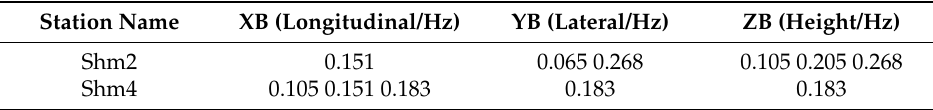
Figure 10 . FFT results of shm2 . Figure 10. FFT results of shm2. Table 5. Dominant Frequencies detected from the baseline time Table 5 . Dominant Frequencies detected from the baseline time series .